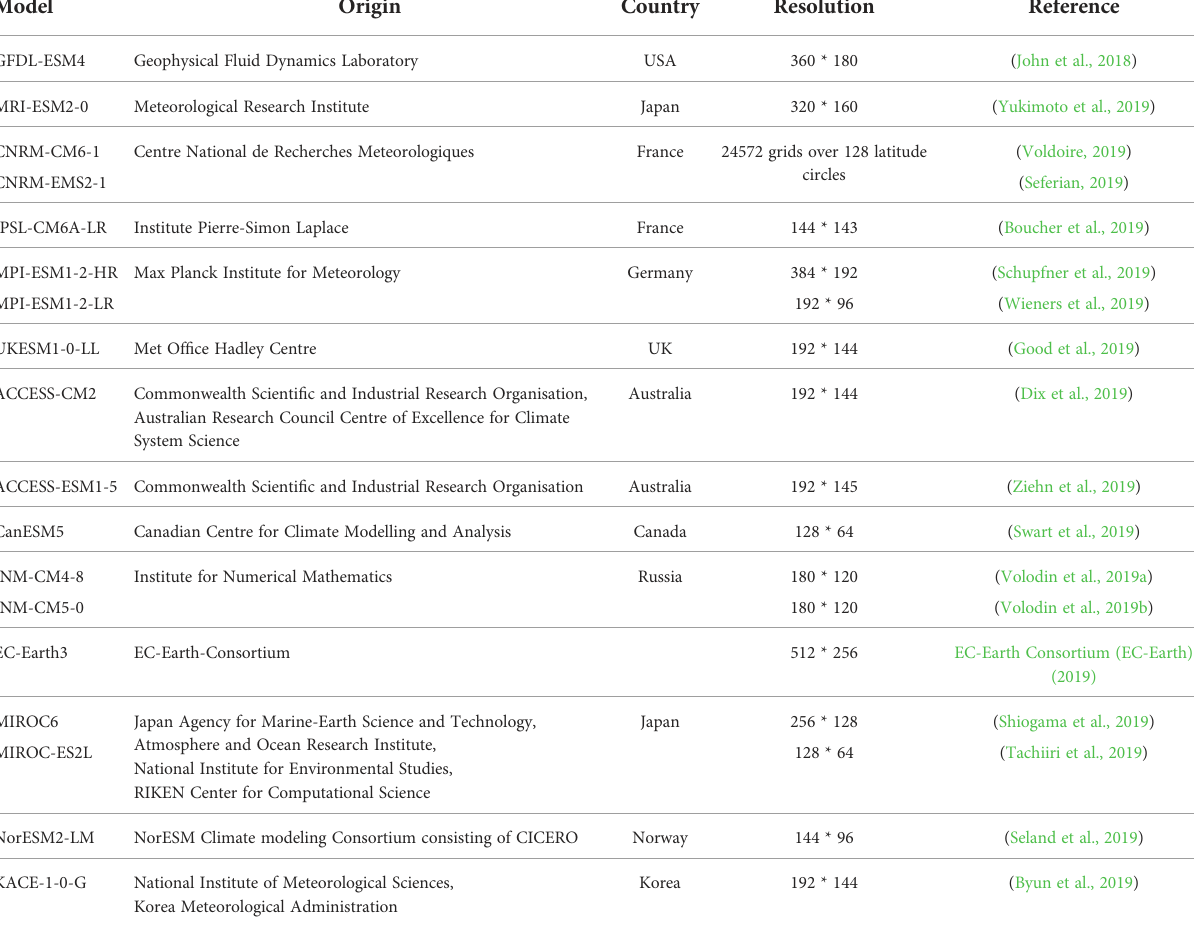
TABLE 1 18 GCMs for the CMIP6 climate change scenarios. Model